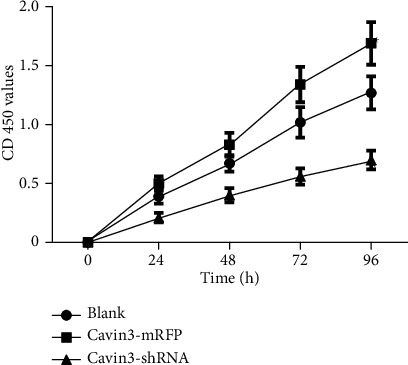
Cell growth curve in lung cancer. Note: ∗ means p < 0.05, N = 3.